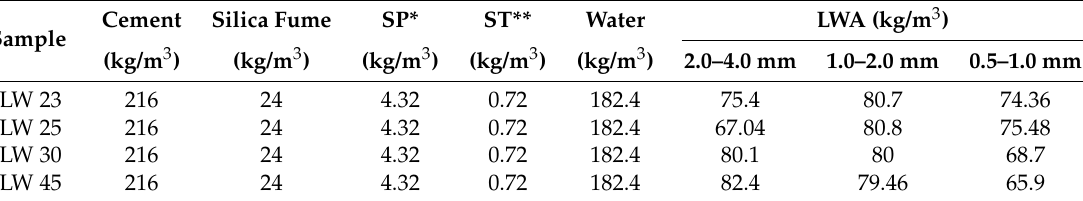
Table 4. Mix proportions of concrete mixes.